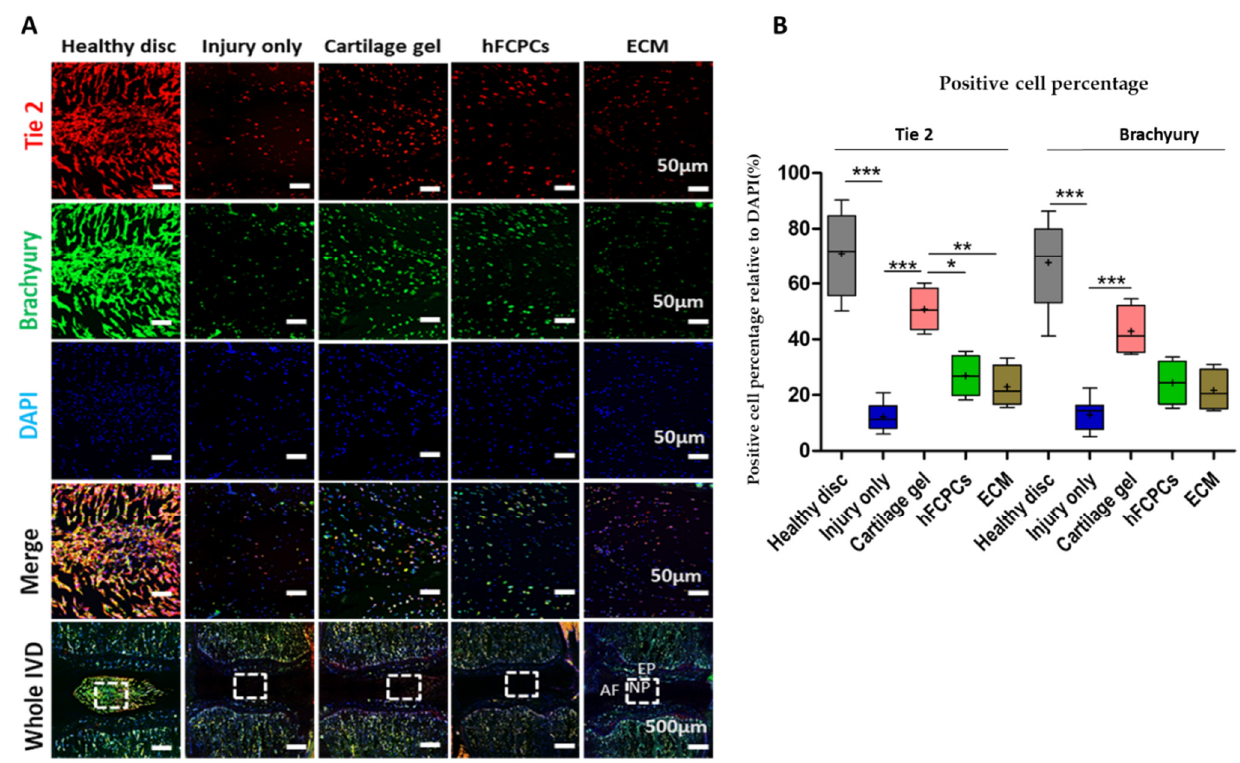
Figure 4. The cartilage gel preserved cells with endogenous phenotype in disc nucleus pulposus (NP) of a rat nucleotomy model. Immunofluorescence images of the indicated genes are presented for the healthy discs, injury-only discs, and the cartilage gel-injected, hFCPCs-injected, or ECM-injected discs at 6 weeks after surgery. ( A ) Immunofluorescence of brachyury (green) and Tie2 (red), DAPI (blue), and merged signals. ( B ) Changes in the percentage of Tie2 or brachyury-positive cells in the disc NP spaces. Immunopositivity was counted in disc NP of low-power fields and calculated as relative to the total number of DAPI-positive cells. In ( A , B ), data are presented with box plots ( n = 4, * p < 0.05; ** p < 0.01, *** p < 0.001, significant difference by one-way ANOVA). hFCPCs, human fetal cartilage-derived progenitor cells; ECM, extracellular matrix.